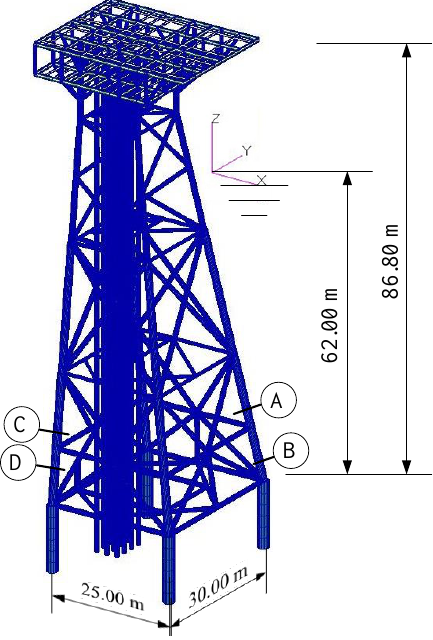
Figure 2. The finite element (FE) model of the jacket platform.